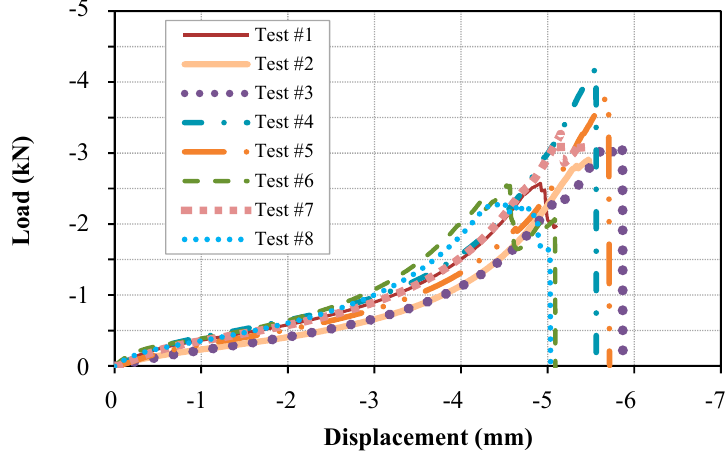
Figure 3. Load-displacement response of uniaxial compression test on Bis-GMA polymer.